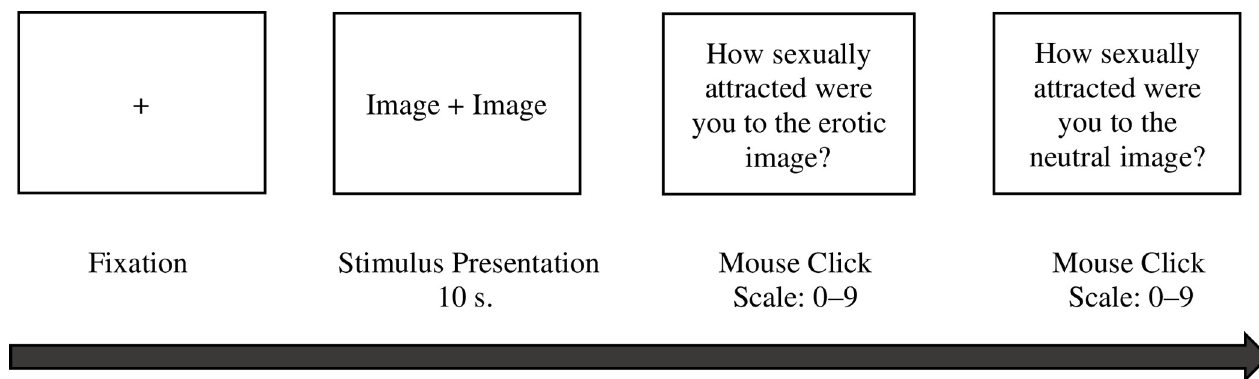
Fig 2. Sample experimental trial in the eye-tracking task. Depiction of the time sequence and visual presentation of a single trial.